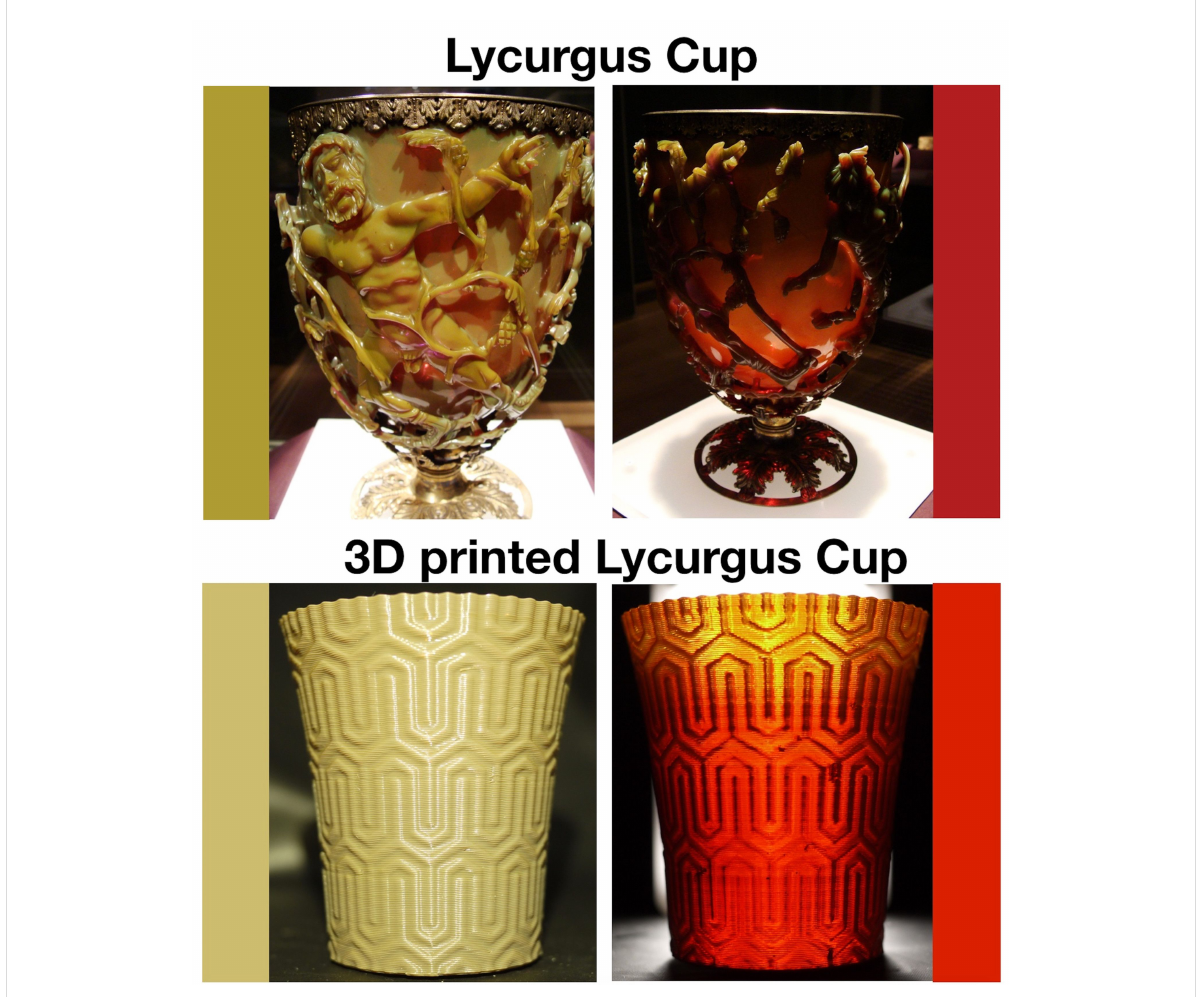
Figure 4: Comparison between the original Lycurgus cup and the 3D printed Ag/Au@PVA nanocomposite cup presented in this research using the flashlight LED as the light source. The boxed colours represent the majority of the colour of the cups in reflection and in transmission. Pictures of the Lycurgus cup provided by the courtesy of Lucas Livingston (ancientartpodcast.org), Copyright (2013) Lucas Livingston (ancientartpodcast.org), published under CC BY 2.0 (https://creativecommons.org/licenses/by/2.0/).